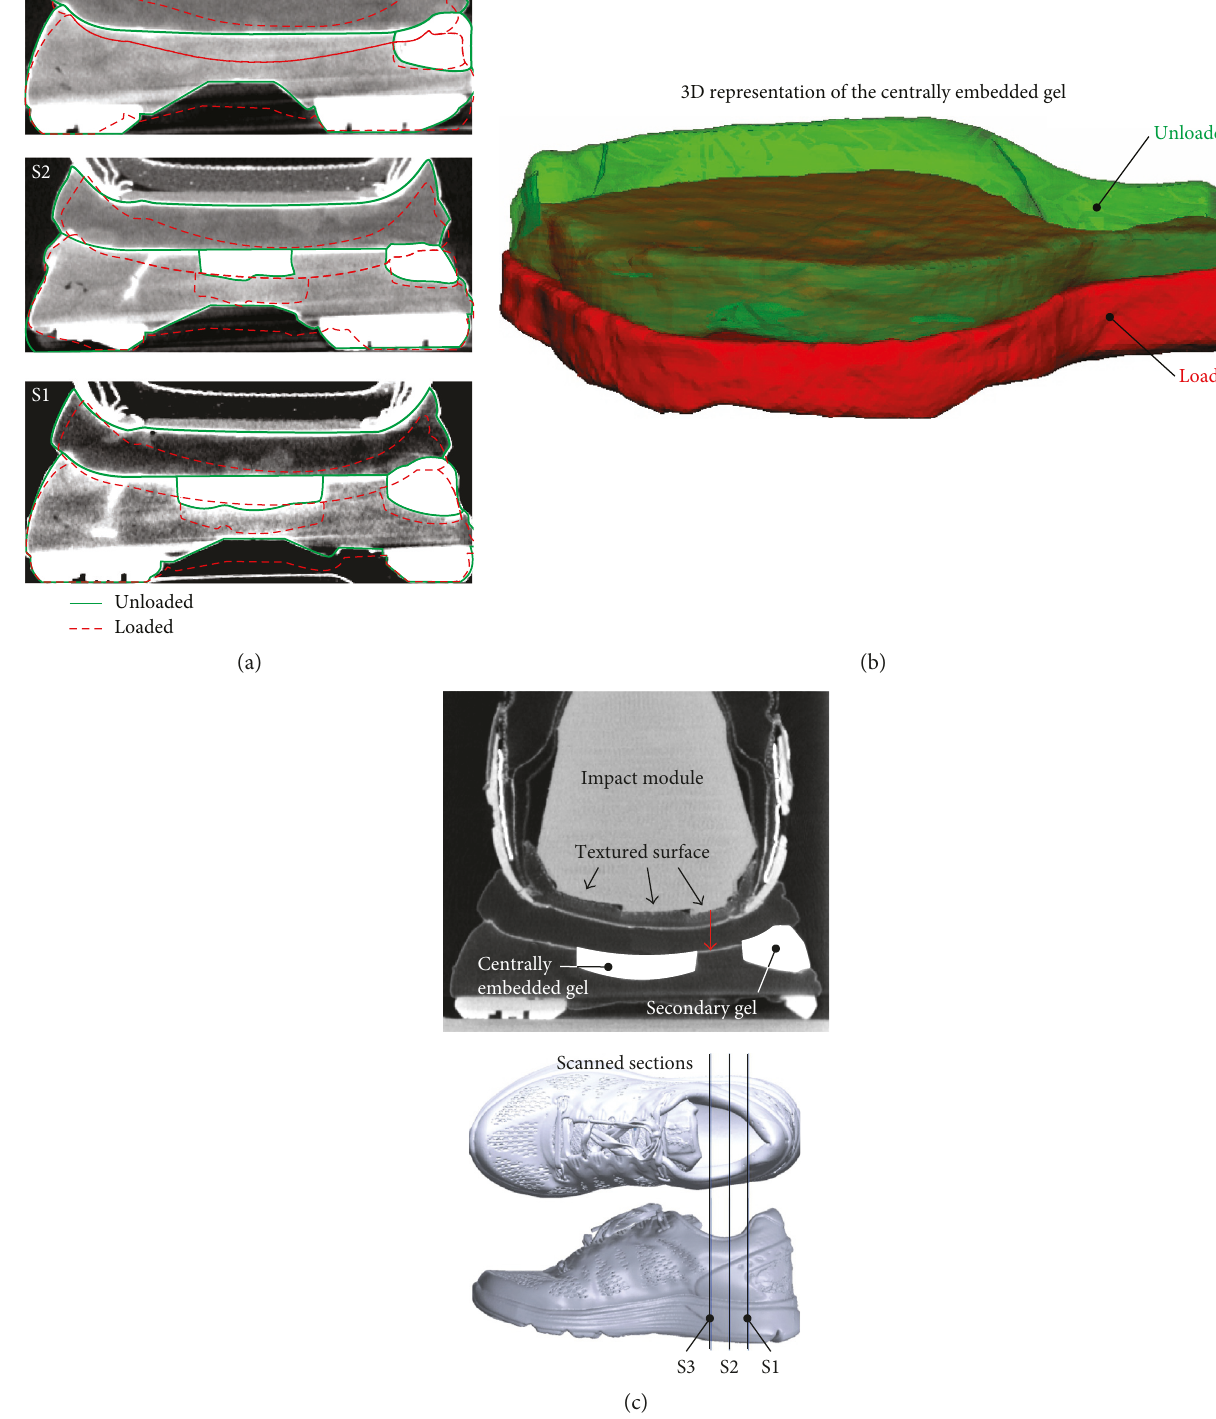
Figure 6: (a) Body mass-speci fi c displacement pro fi le at di ff erent anterior-posterior cross sections of the shoe. (b) 3D deformation of the central gel. (c) O ff -axis positioning of the embedded gel (as for normal